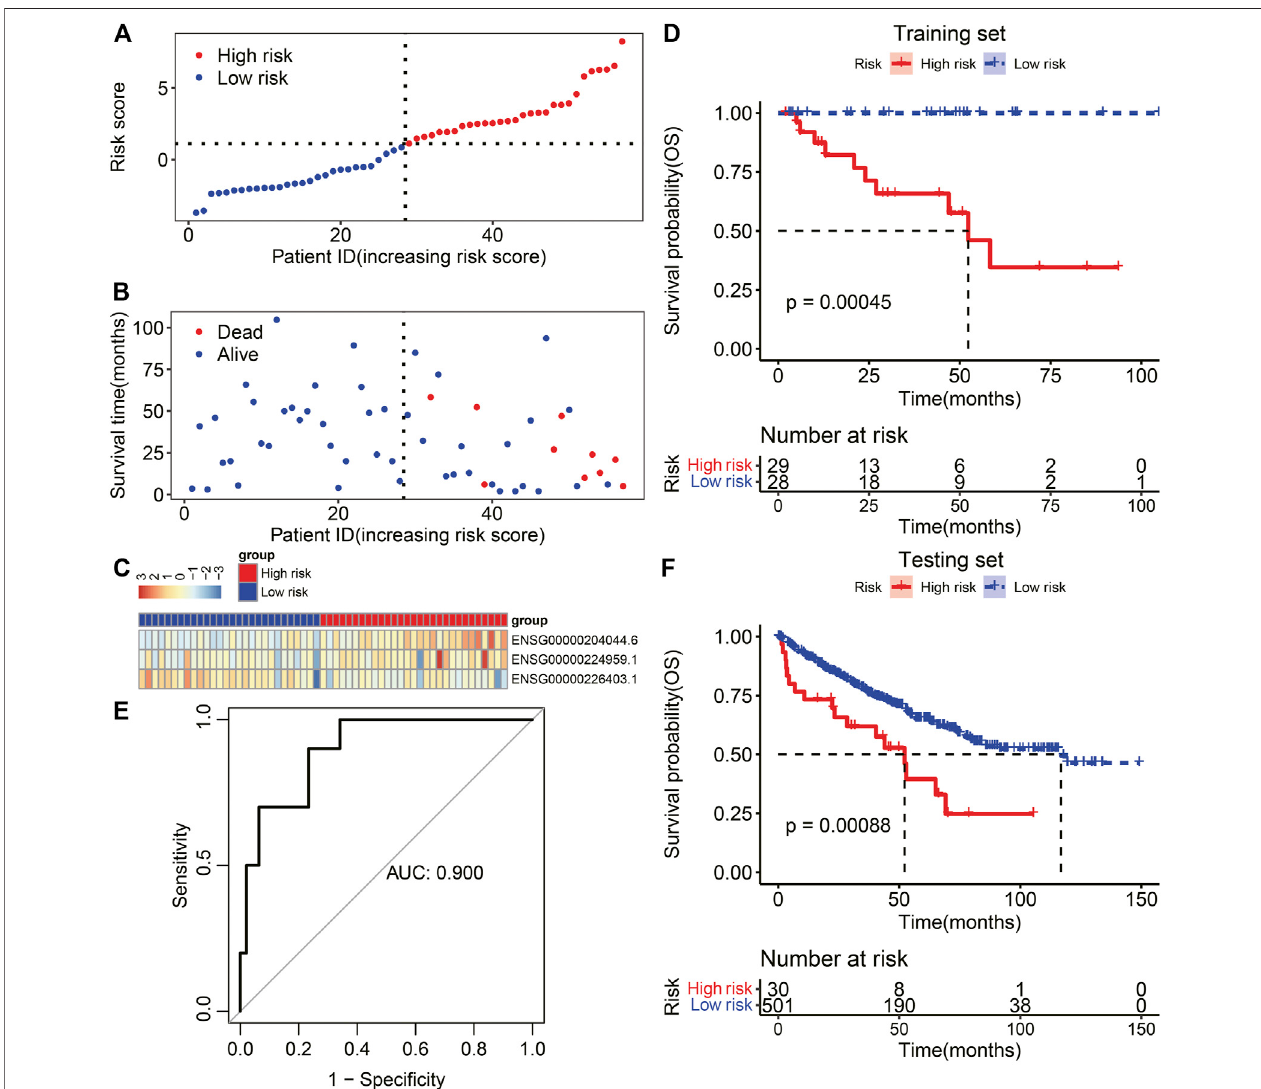
FIGURE 8 | Evaluation and validation of TIR-lncRNA signature in RCC. (A) The risk curve of each sample was reordered by risk score. The red and blue dots representhigh-riskandlow-risk,respectively (B) Patientsinthehigh-riskgroupshowedhighermortalitythanthoseinthelow-riskgroup.Theredandbluedotsrepresent deathandsurvival,respectively. (C) Heatmapshowedscaledexpressionlevelsofprognosis-relatedTIR-lncRNAsinthelow-riskandhigh-riskgroups. (D) Patientsinthe high-riskgroup(red) exhibitedworse OSthanthoseinthe low-riskgroup (blue)inthe trainingset. (E) TheAUCvalues forforecasting OSstatus using theriskscore in the training set. (F) Patients in the high-risk group (red) exhibited worse OS than those in the low-risk group (blue) in the testing set.